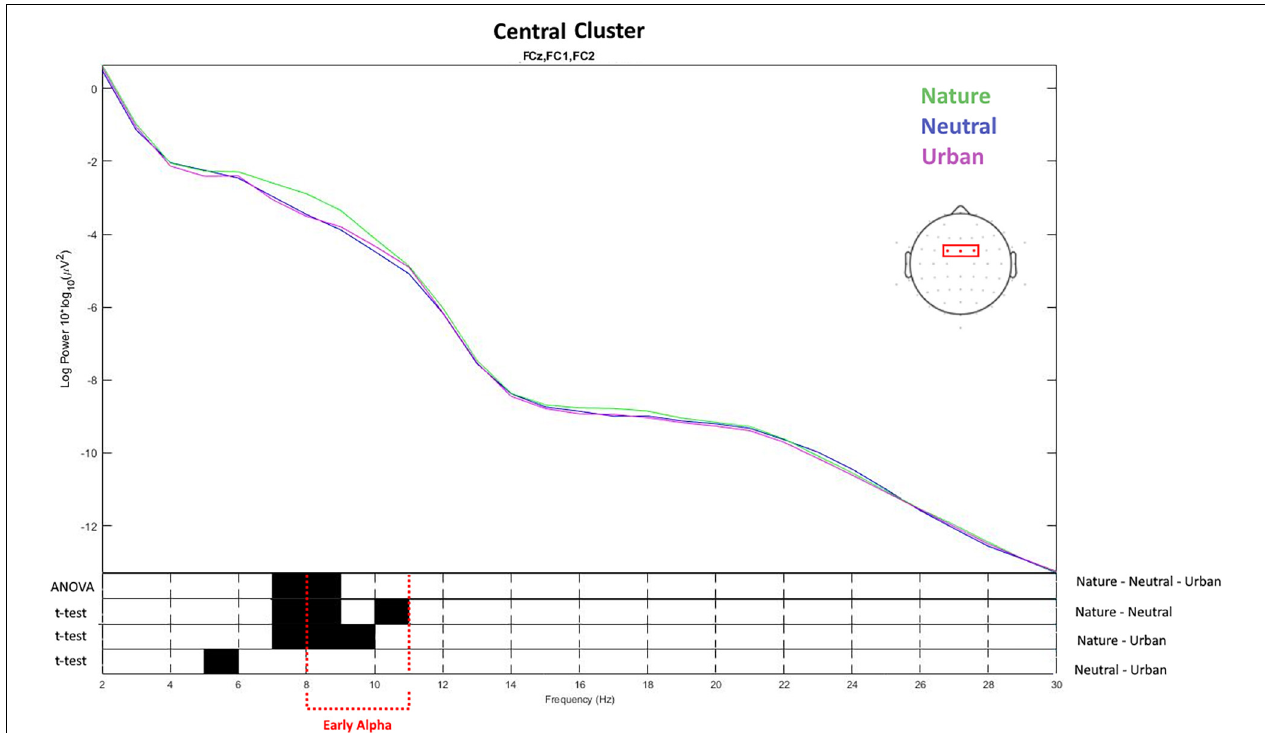
FIGURE 5 | The top of the figure presents the values of spectral power obtained averaging the values for the electrodes placed over the central brain area. The frequency ( X -axis) and spectral power ( Y -axis) for the three experimental conditions (neutral, nature, and urban videos). The bottom of the figure shows the results of ANOVA and t -tests on the differences between the conditions on the spectral power for each frequency from 2 to 30 Hz. The black color shows the frequency values in which the spectral power values were statistically different between the conditions.